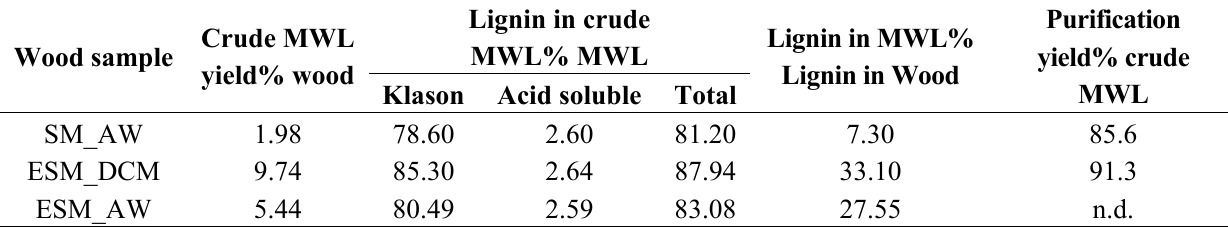
Table 3. Results of milled wood lignin (MWL)